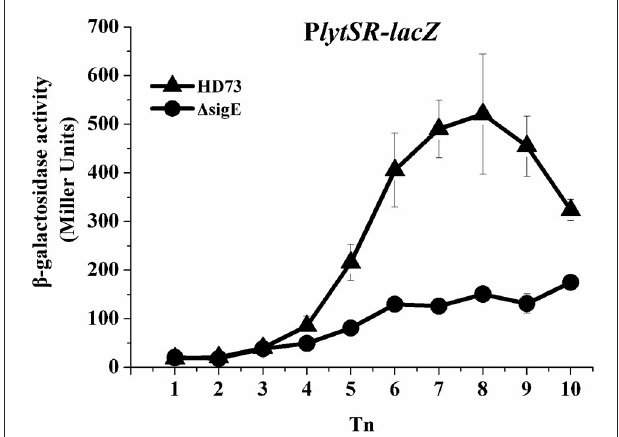
FIGURE 6 | Transcription of P lytSR promoter in Bt . Wild-type HD73 ( N ) and sigE mutant cells (•) were grown in SSM. T 0 is the end of the exponential phase, and T n is n hours after T 0 . Values represent the means of at least three independent replicates; error bars represent standard deviations.